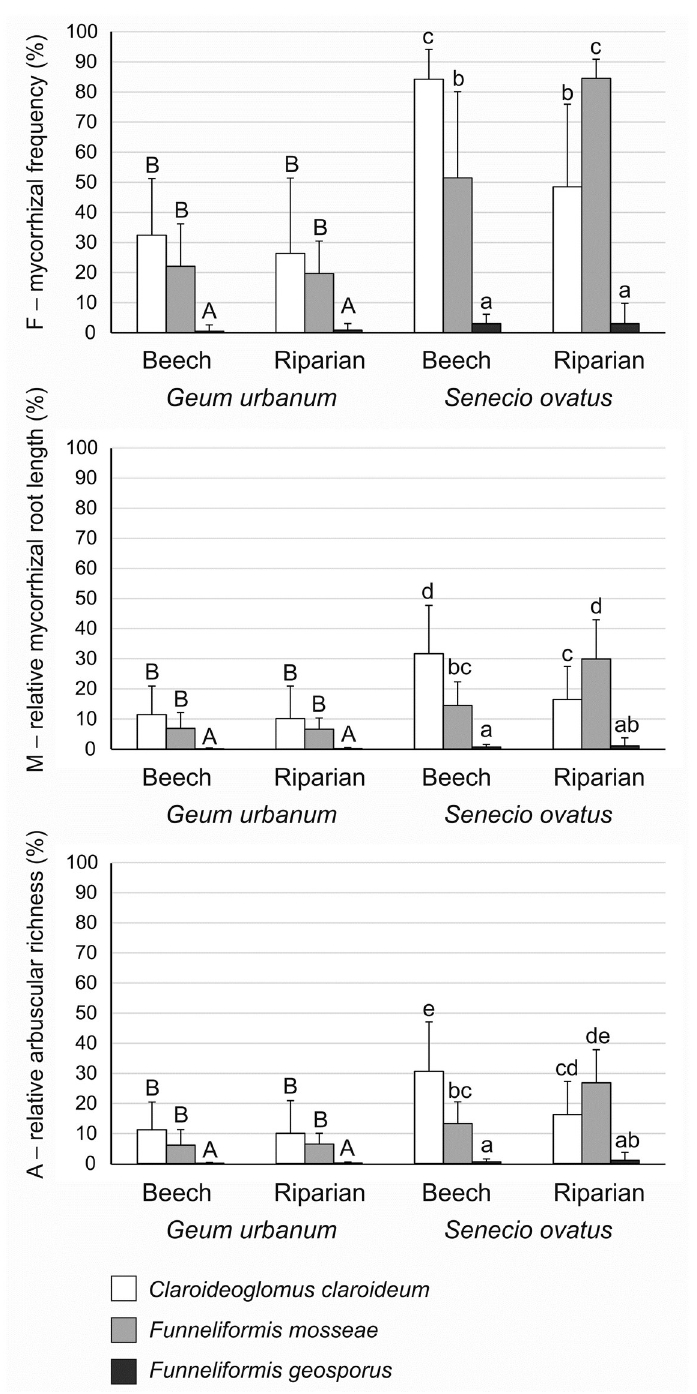
Fig 1. Mycorrhizal colonisation (percentages; mean ± SD) of Geum urbanum and Senecio ovatus grown in beech and riparian soils. Mycorrhizal parameters: mycorrhizal frequency (F); relative mycorrhizal root length (M); relative arbuscular richness (A). Within each plant species, lowercase letters above the bars indicate statistically significant interaction between fungus and soil effects; uppercase letters indicate the significant main effect of fungus; different letters above the bars indicate statistically significant differences; for each, p < 0.05. See Table 2 for details on the main effects and interactions.